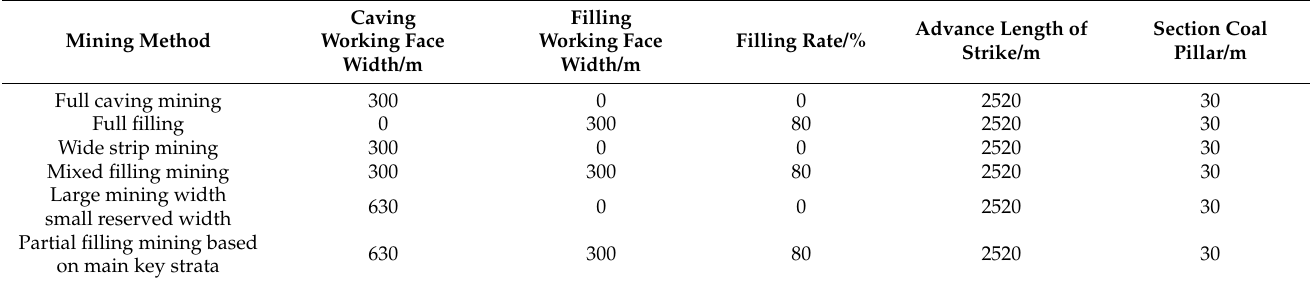
Table 13. Scheme designs of different mining modes.